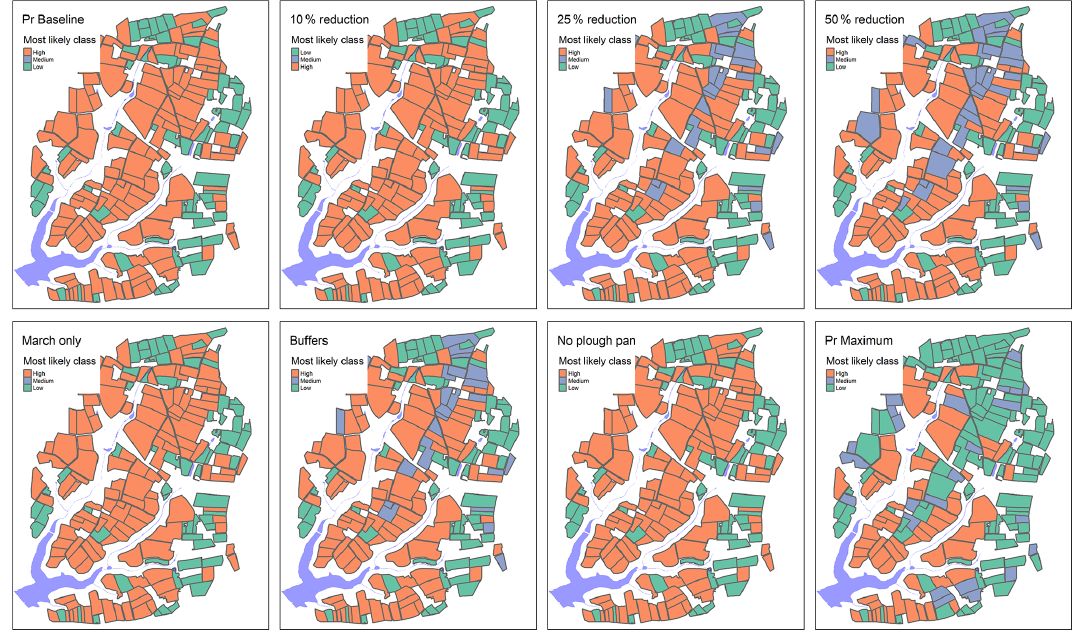
Figure B3. Most likely overland flow risk class for prosulfocarb under current application practices; with a 10%, 25%, or 50% reduction in the application rate; with a time shift of application to March; with additional field buffers; with no plough pan; and with all mitigation measures combined.